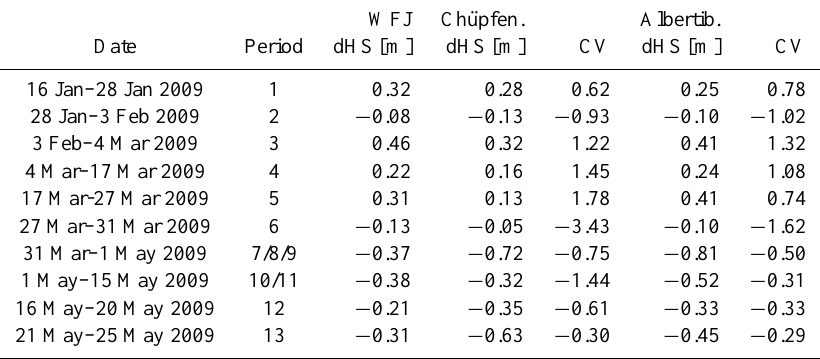
Table 2. Observation periods (given by two following TLS measurements), snow depth change (dHS) at the Versuchsfeld Weissfluhjoch (WFJ), the Ch¨upfenflue (Ch¨upfen.) and the Albertibach catchment (Albertib.) and their variability (CV). The periods refer to the periods used in Table 3.